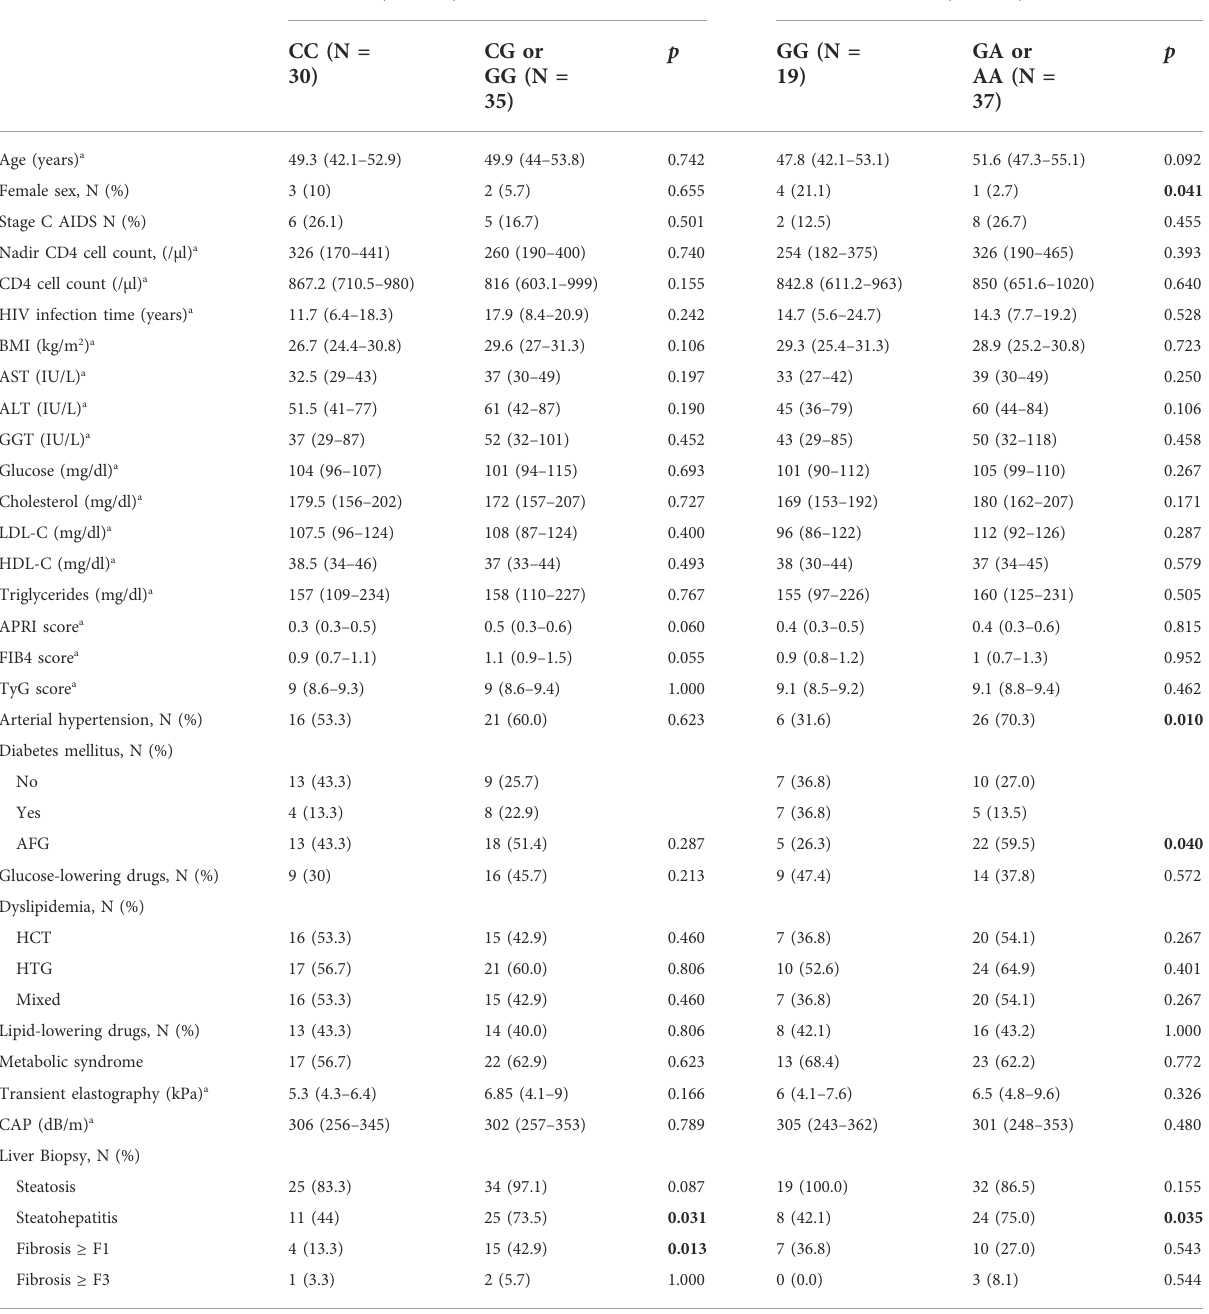
TABLE 2 Patient characteristics according to polymorphisms in PNPLA3 and MBOAT7-TMA